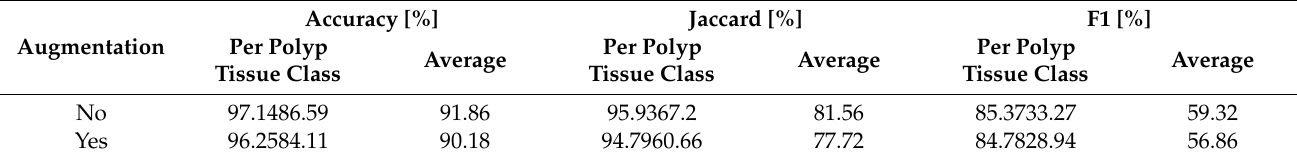
Table 9. Results on “CVC-ClinicDB”